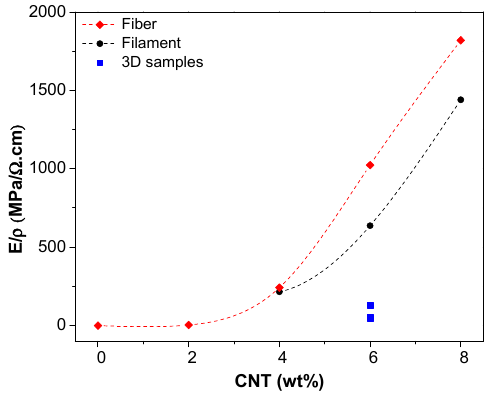
Figure 14. The ratio modulus/resistivity reference at 5 V as a function of CNT % for filament ( ● ), fiber ( ♦ ) and 3D samples ( ■ ).